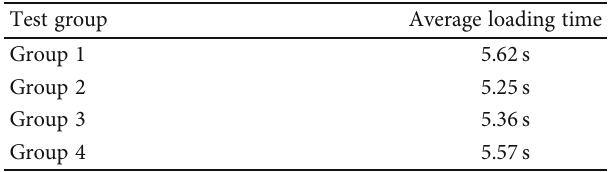
Table 1: Real-time display page loading time of